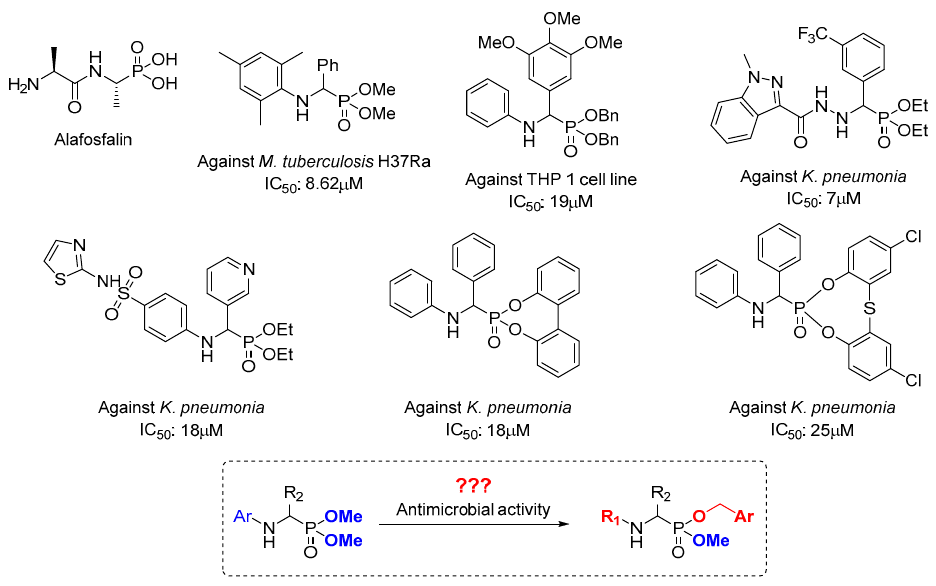
Figure 1. Biologically active antimicrobial α -aminophosphonate derivatives.